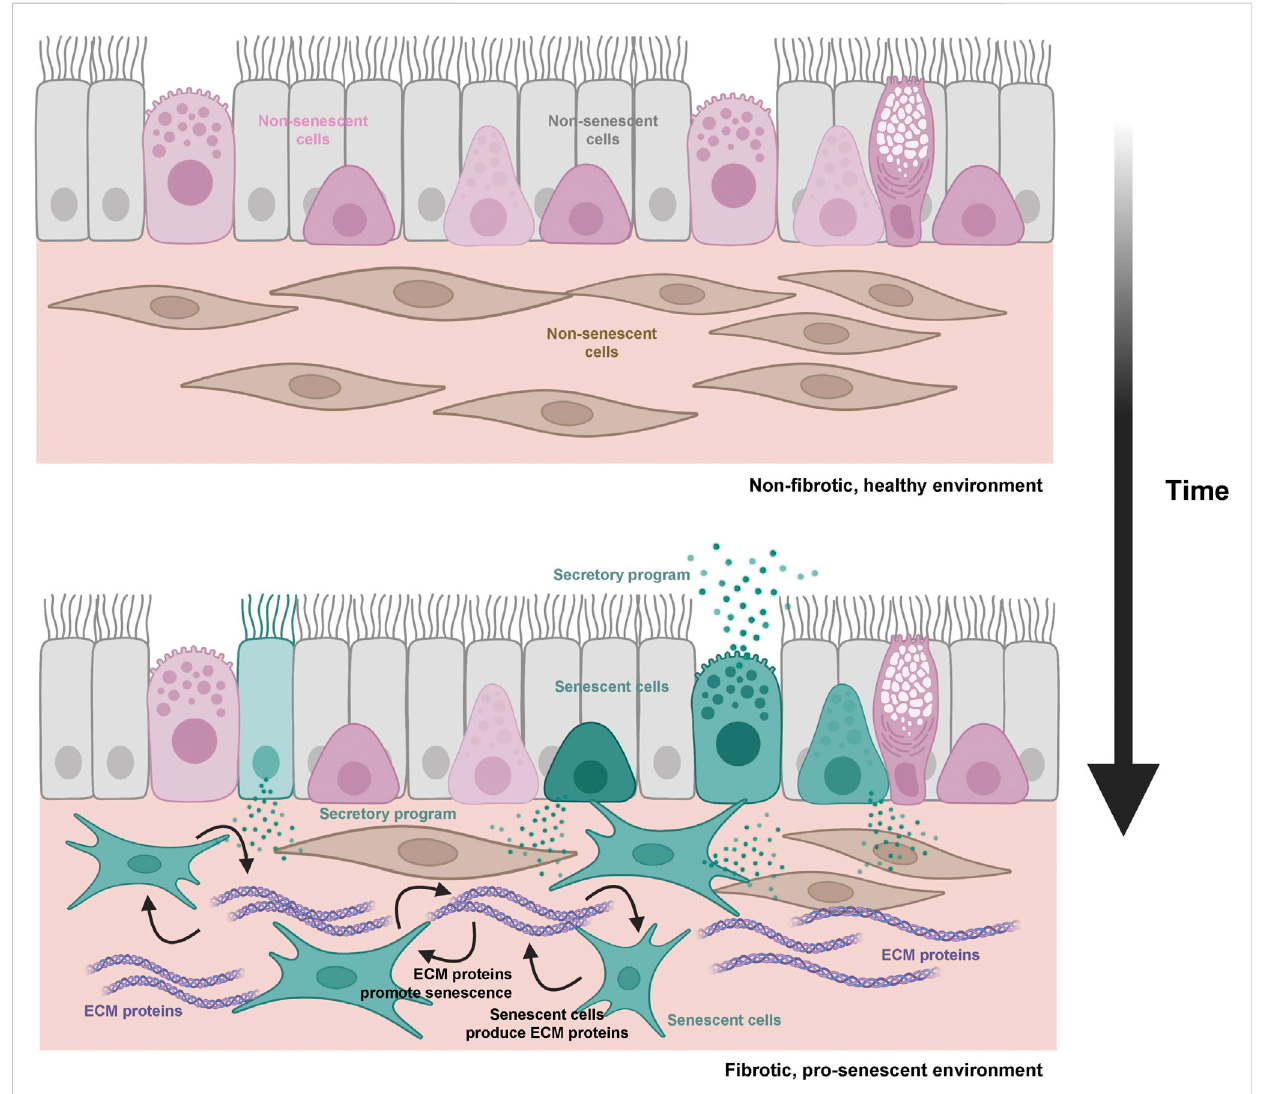
FIGURE 3 Schematic representation of the hypothesis connecting aging, fi brosis, and cellular senescence. During aging, accumulating senescent cells (teal) and ECM pro- fi brotic proteins (purple) can engage in a cycle in which both processes are reciprocally stimulated (regulatory loops are represented by black